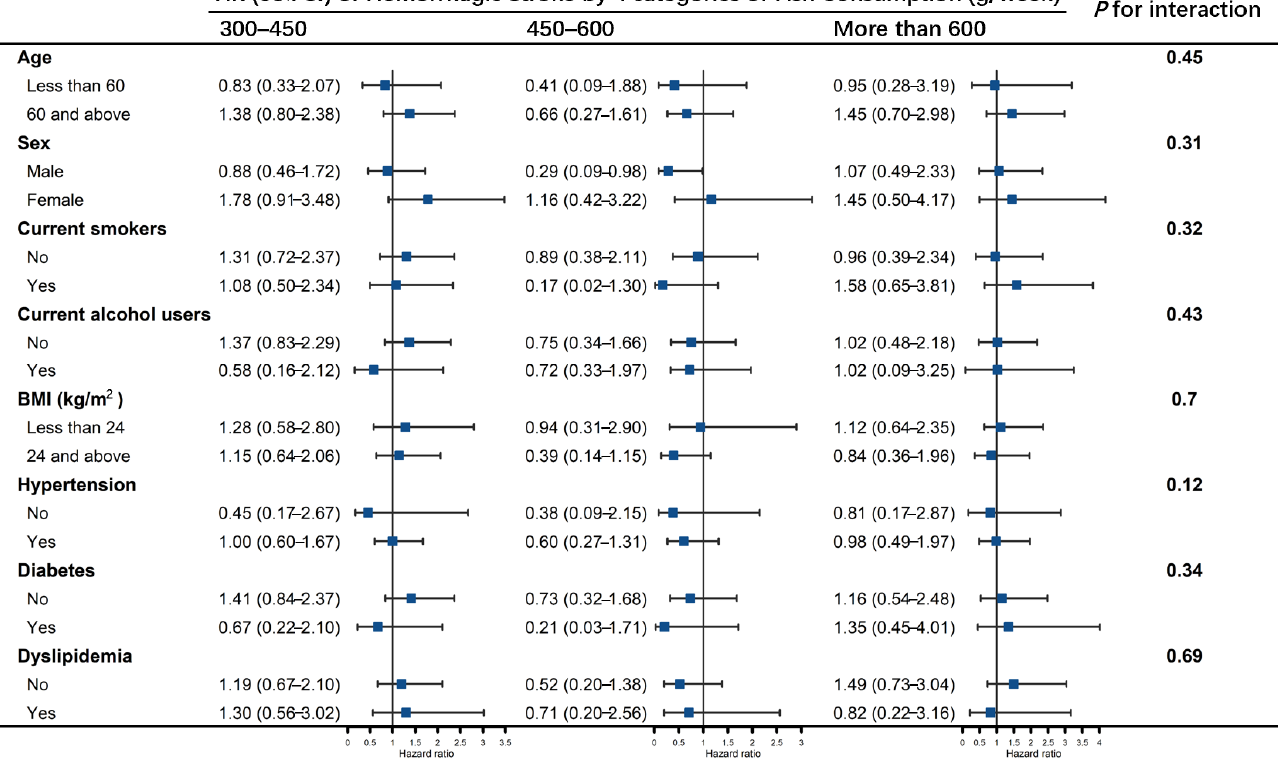
Figure 5. Association of fish consumption (g/week) between the risk of hemorrhagic stroke by subgroups of age, sex, smoking status, alcohol drinking status, BMI groups, history of hypertension, diabetes, and dyslipidemia. The model was adjusted for age, sex, educational levels, marital status, retirement status, smoking status, alcohol drinking status, physical activity levels, sleep qualities, obesity status, dietary energy intakes, consumption of fruit, vegetables, peanuts, wholegrains, processed and unprocessed meats, bean products, salt and oil, histories of chronic diseases, including hypertension, CHD, diabetes, CKD, dyslipidemia, HUA, HHcy, COPD, chronic bronchitis and asthma (the same as covariates in Model 3). Each subgroup analysis was adjusted for all the covariates listed above except itself.